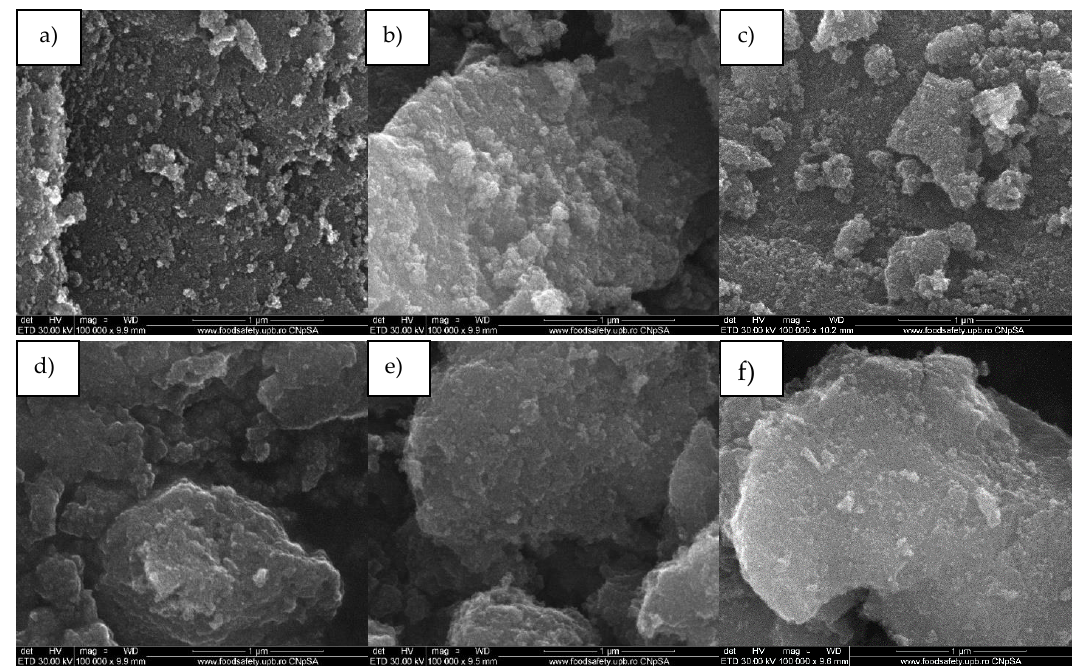
Figure 7. SEM images of nanoparticles ( a ) TiO 2 SG, ( b ) TiO 2 @Ag SG, ( c ) TiO 2 @Fe SG, ( d ) TiO 2 H, ( e )TiO 2 @Ag H, ( f ) TiO 2 @Fe H.